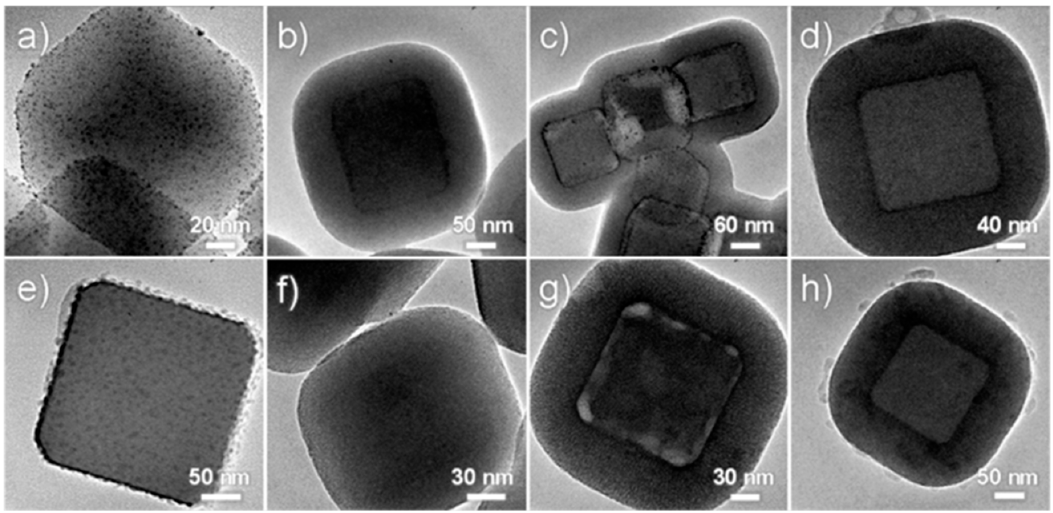
Figure 10. TEM images for ( a ) ZIF-8@Au after calcination, ( b ) ZIF-8@Au@mSiO 2 before calcination, ( c